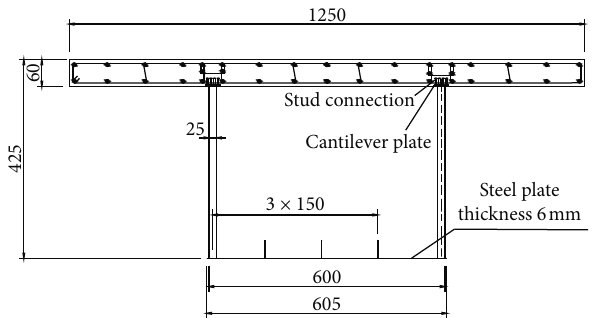
Figure 7: Unit cross-section of single box girder (unit: mm). Figure 8: Diagram of half upper flange and half bottom plates of the single box and single chamber composite box girder with CSWSB (unit: mm).